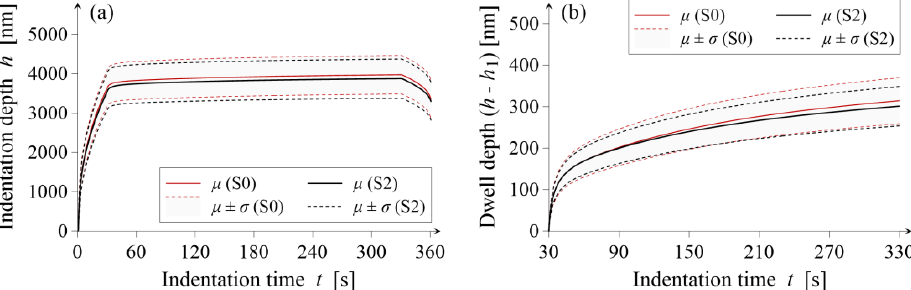
Figure 11. ( a ) Average indenter immersion during all the indentation phases and (b) average immersion in the creep phase only. Results for sample S3 versus the reference sample S0. To compare the obtained results, Table 6 presents the average values μ and standard deviations σ of the creep coefficient C IT for all the tested series of self-compacting cement matrices. Table 6. Mean values ( μ ), standard deviations ( σ ), and the creep coefficient ( C IT ). Concrete series